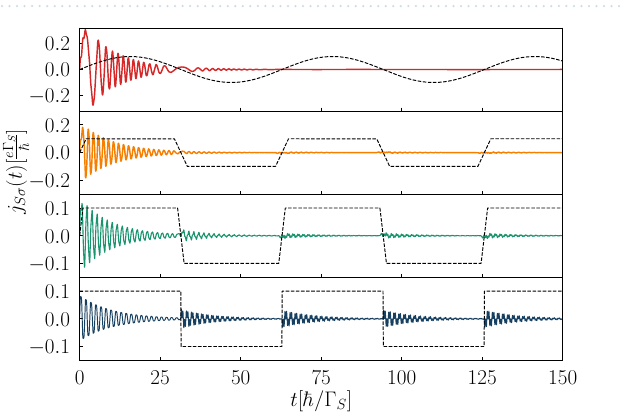
Figure 6. Amplitude effect of periodic driving. The current j S σ induced by the oscillating energy levels ε i σ ( t ) A sin (ω t ) . Panel ( a ) presents the results obtained in uncorrelated system for V 12 /Ŵ S = amplitudes A . Panel ( b ) shows the mean-field results determined for V 12 /Ŵ S of the Coulomb potential U (in units of Ŵ S ). We used the model parameters V sd The dashed lines illustrate profile of the oscillating energy levels (not in scale).